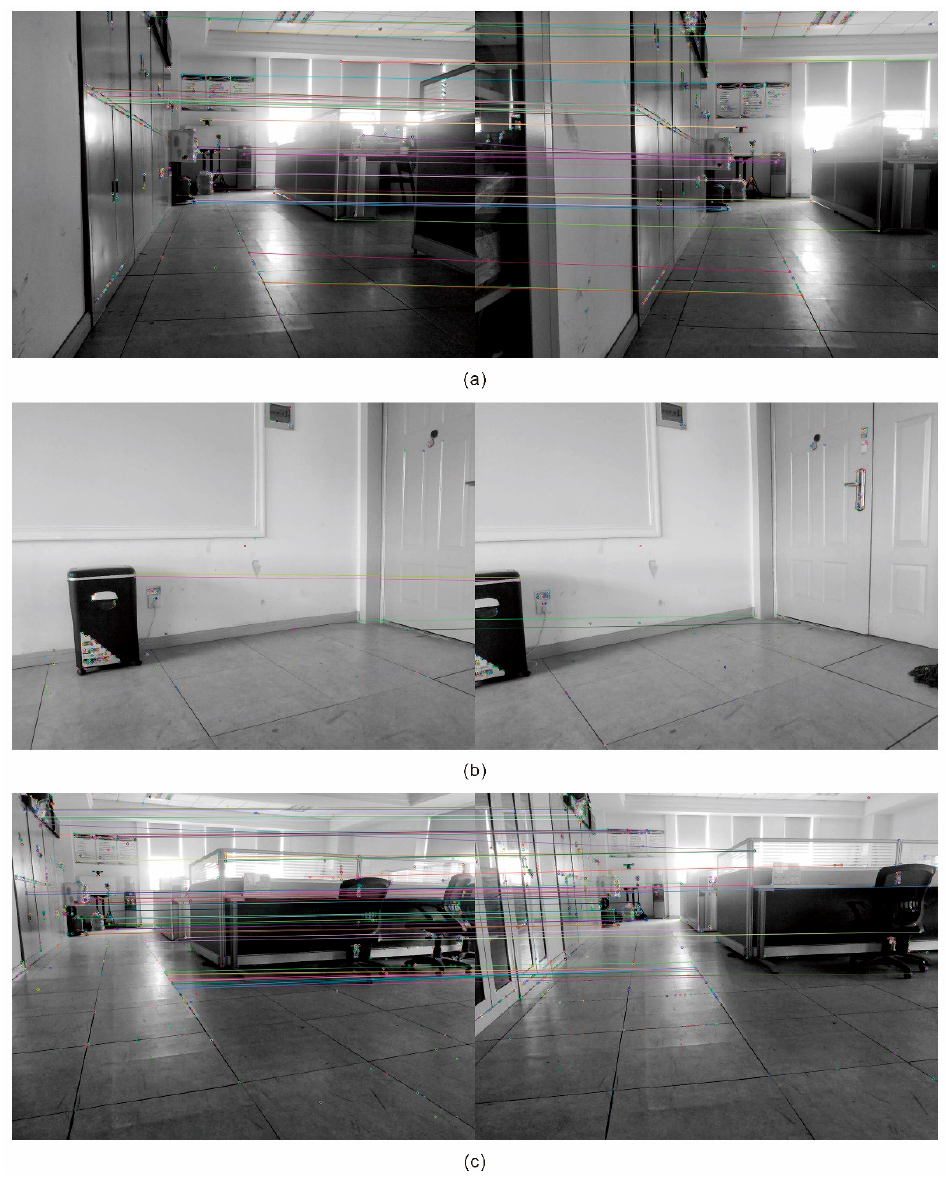
Figure 5. Matching of feature points of aisles ( a ), corners ( b ), tables and chairs ( c ). The matching success rates of the aisle, corner, desk, and chair scenes are 9.38%, 2.68%, and 11.63%, respectively. This indicates that the scenes with rich textures, obvi- ous structures, and strong characteristics include more feature points and have a higher matching success rate. On the contrary, the scenes with weak texture and a single structure have fewer feature points detected hence a lower matching success rate. It is also seen that in these 19 different scenarios, the highest matching success rate is 43% and is never larger than 50%. Based on the results above, we added further 7 experimental scenes with artificial features that improve the matching success rate to 87.37%, as shown in Figure